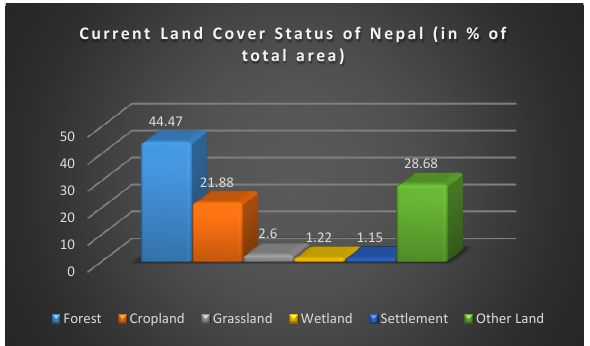
Figure 1. Current land cover status of